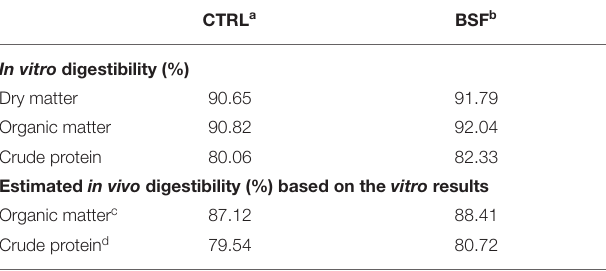
TABLE 3 | Comparison of the in vitro digestibility of the two diets (CTRL vs. BSF) and estimated in vivo digestibility based on the in vitro results. CTRL a BSF b In vitro digestibility